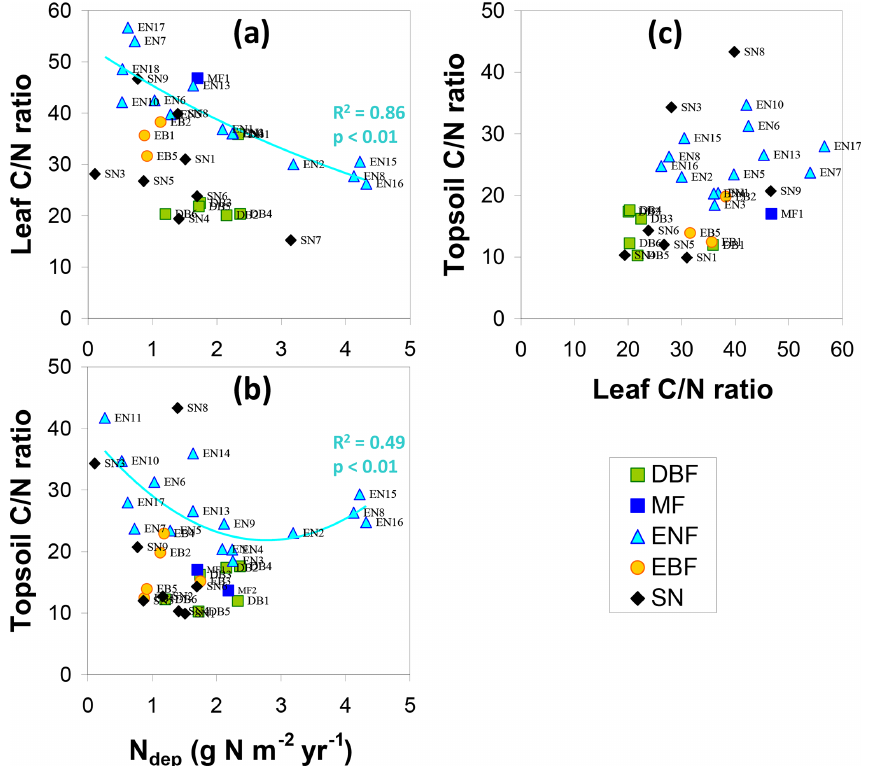
Figure 9. Relationships of leaf (a) and topsoil (b) C / N ratios with atmospheric nitrogen deposition ( N dep ), and to each other (c) , in different ecosystem types (DBF: deciduous broadleaf forests, MF: mixed forests, ENF: evergreen needleleaf forests, EBF: evergreen broadleaf forests, SN: short semi-natural